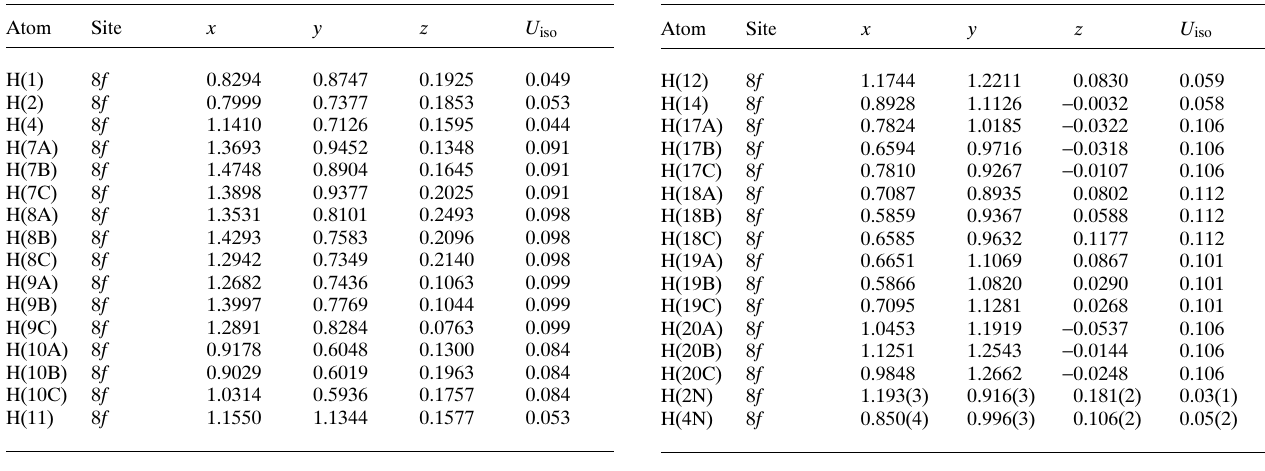
Table 2. Atomic coordinates and displacement parameters (in Å 2 )